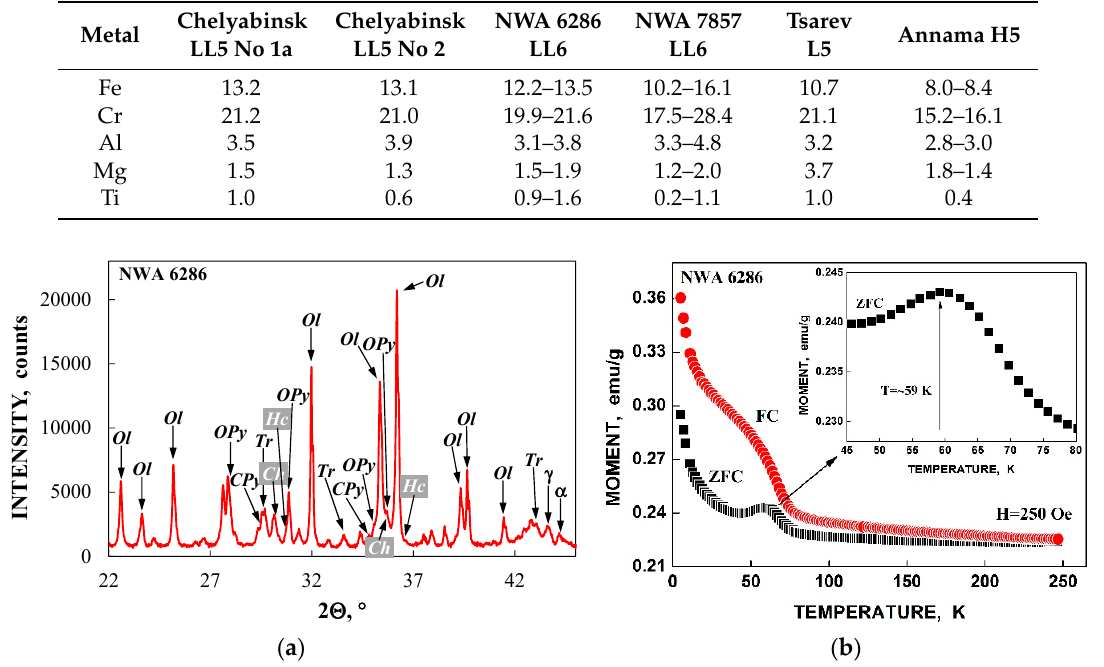
Figure 3. Characterization of the powdered bulk NWA 6286 matter: ( a ) X-ray diffraction pattern with indication of some reflexes of the iron-bearing phases: Ol is olivine, OPy is orthopyroxene, CPy is clinopyroxene, Tr is troilite, Ch is chromite, Hc is hercynite, α is α -phase, and γ is γ -phase. ( b ) Zero-field-cooled (ZFC) and field-cooled (FC) magnetization curves with inset that shows an enlarged part of ZFC curve indicated the phase transition in chromite. Adopted from [13]. Table 2. Phase composition (in wt.%) of some ordinary chondrites determined by X-ray diffraction. Phase/mineral